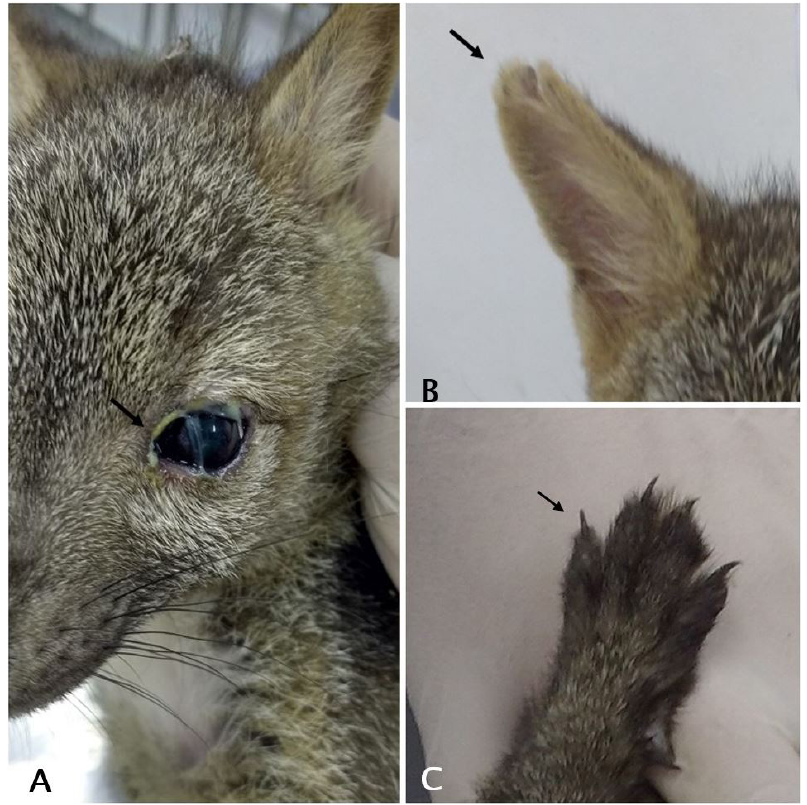
Figure 1. Lesions (arrows) of visceral leishmaniasis in Cerdocyon thous . (A) Ocular lesion; (B) Dermatopathy; and (C)